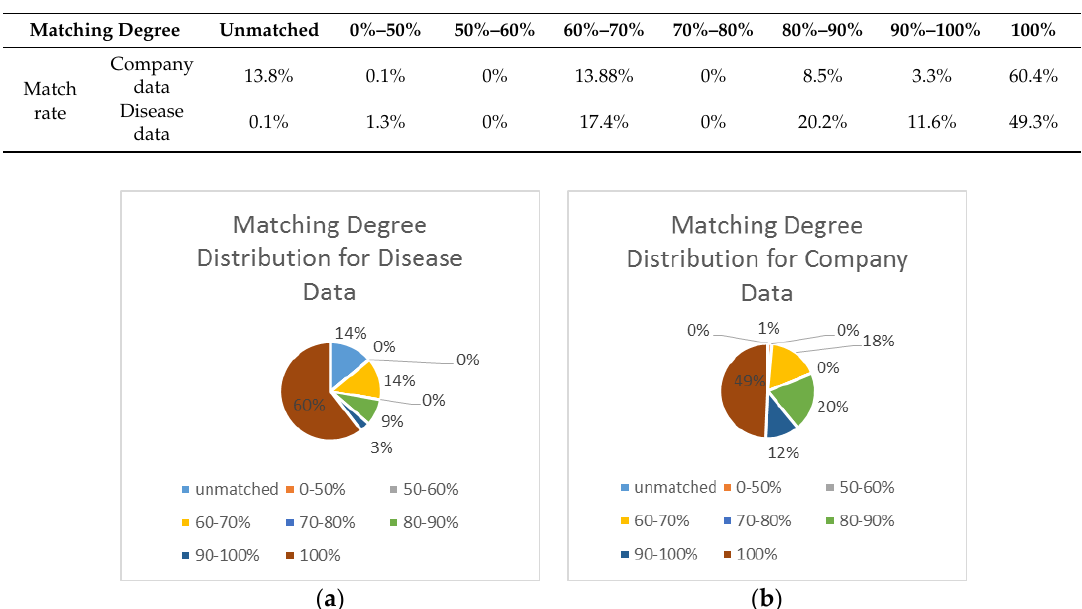
Figure 14. Matching degree distributions: ( a ) matching degree result for the disease data; and ( b ) matching degree results for the company data.